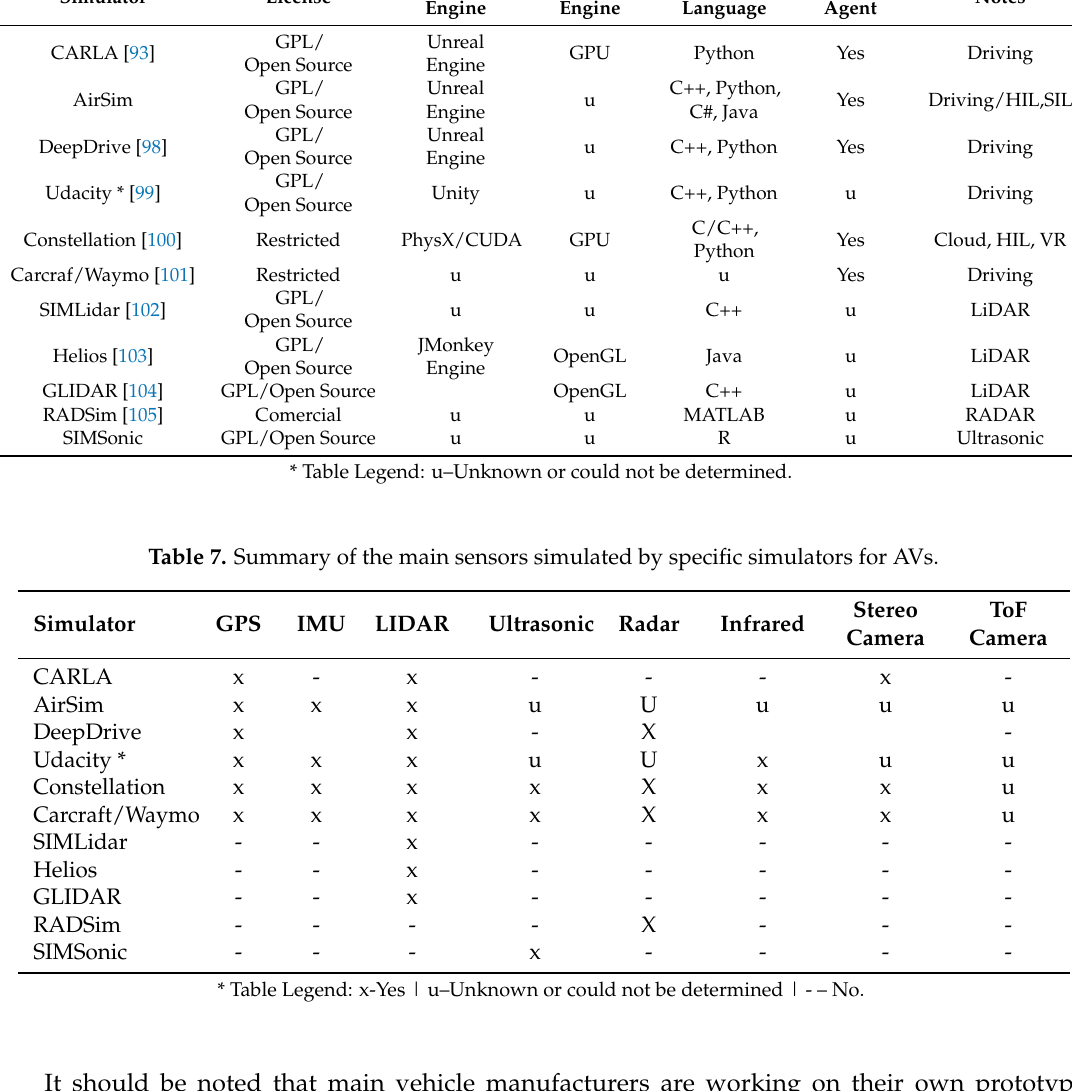
Table 6. Summary of the features of specific simulators for AVs.